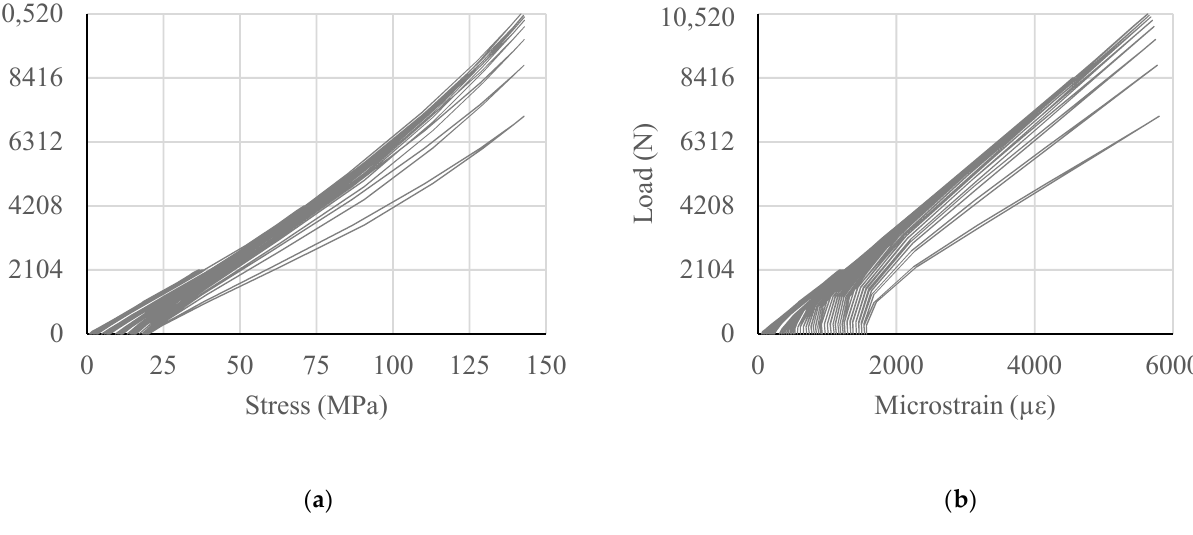
Figure 9. GFRP tie curves ( a ) Load versus stress; and ( b ) Load versus strain.